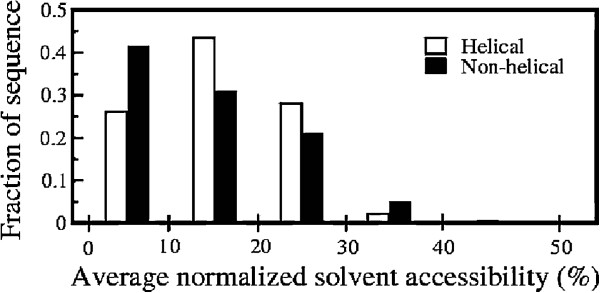
Fraction of sequences vs. average solvent accessibility. Fraction of helices and their corresponding mutation generated sequences in non-helical conformations with different average normalized solvent accessibility. The solvent accessibility of each residue was calculated using DSSP and normalized as depicted in the text.